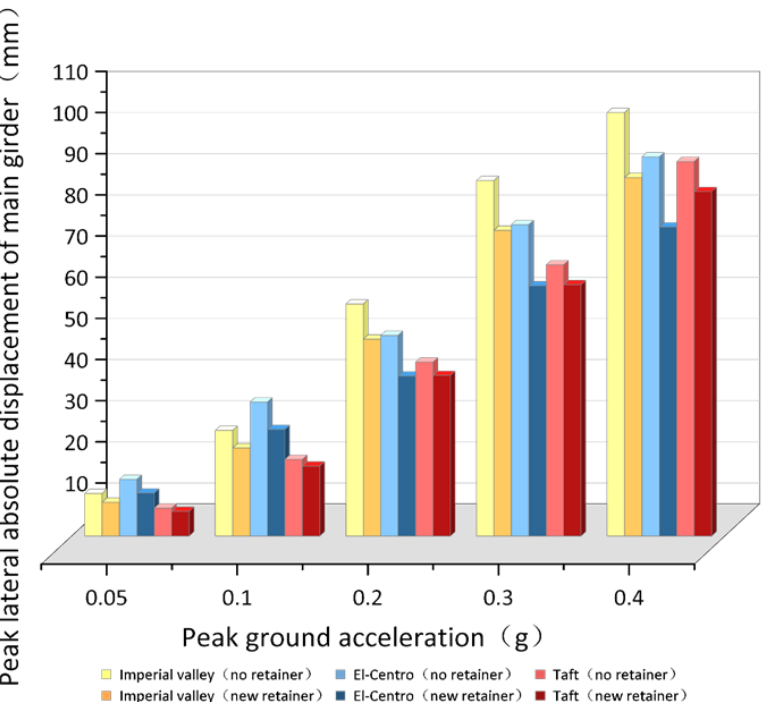
Figure 22. Contradistinction of the peak value of transverse absolute displacement of the girder.